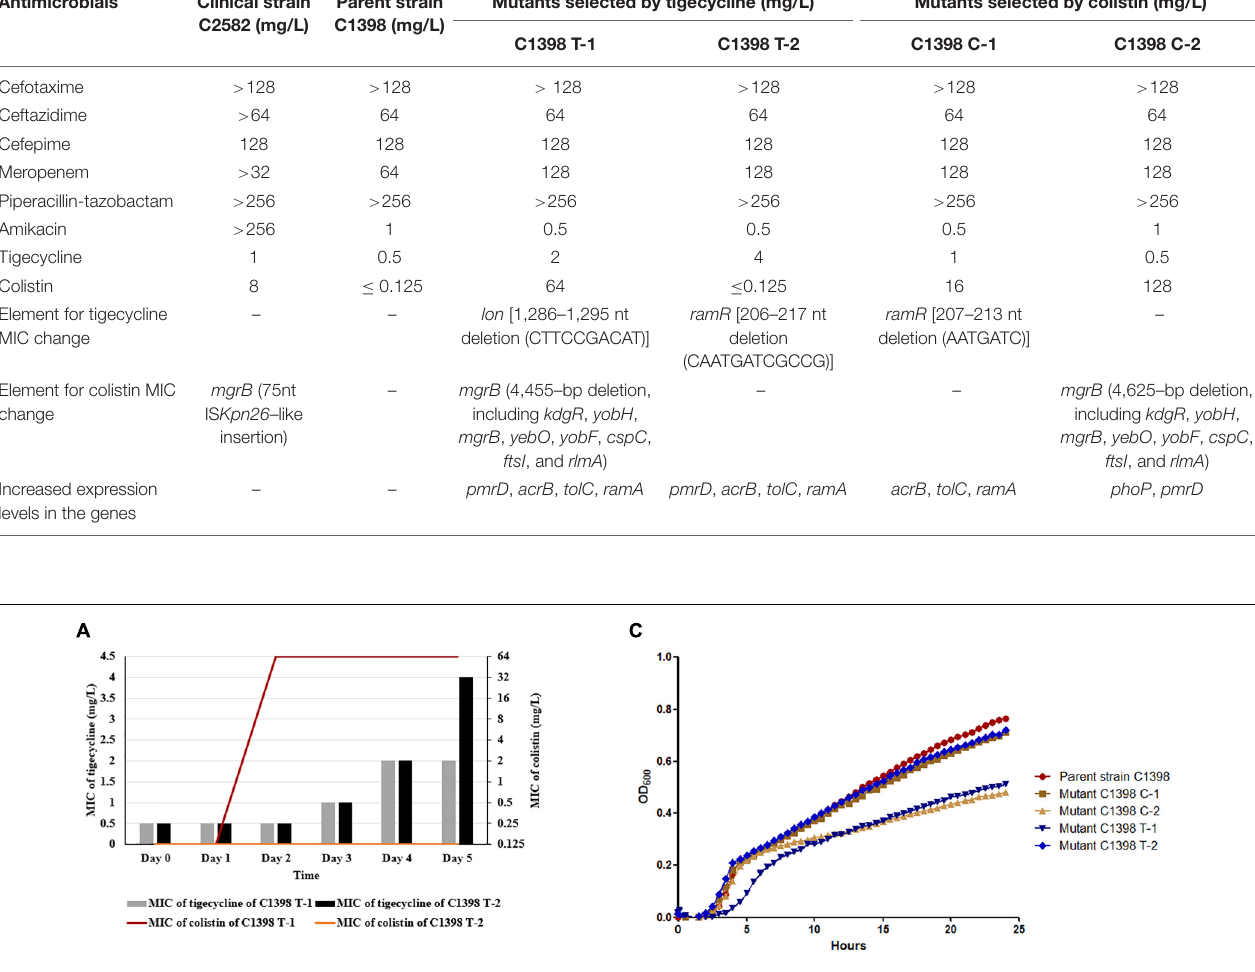
TABLE 1 | Antimicrobial susceptibility profiles and the resistance determinants of the clinical CR-hvKP strain C2582, parent CR-hvKP strain C1398, and the corresponding mutants of C1398 selected by colistin and tigecycline on the fifth day. Antimicrobials Clinical strain C2582 (mg/L)